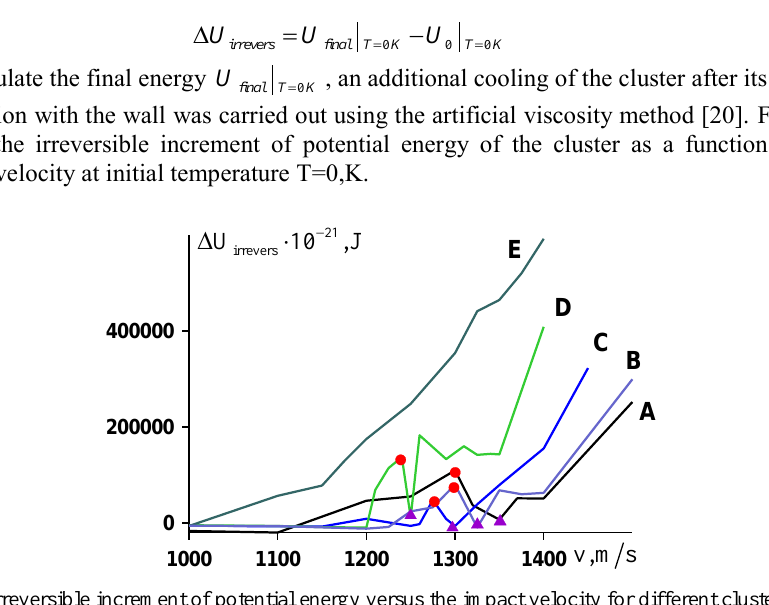
Fig. 4. Irreversible increment of potential energy versus the impact velocity for different cluster initial temperatures: A - 0 K, B - 176 K, C – 345 K, D – 688 K, E – 1008